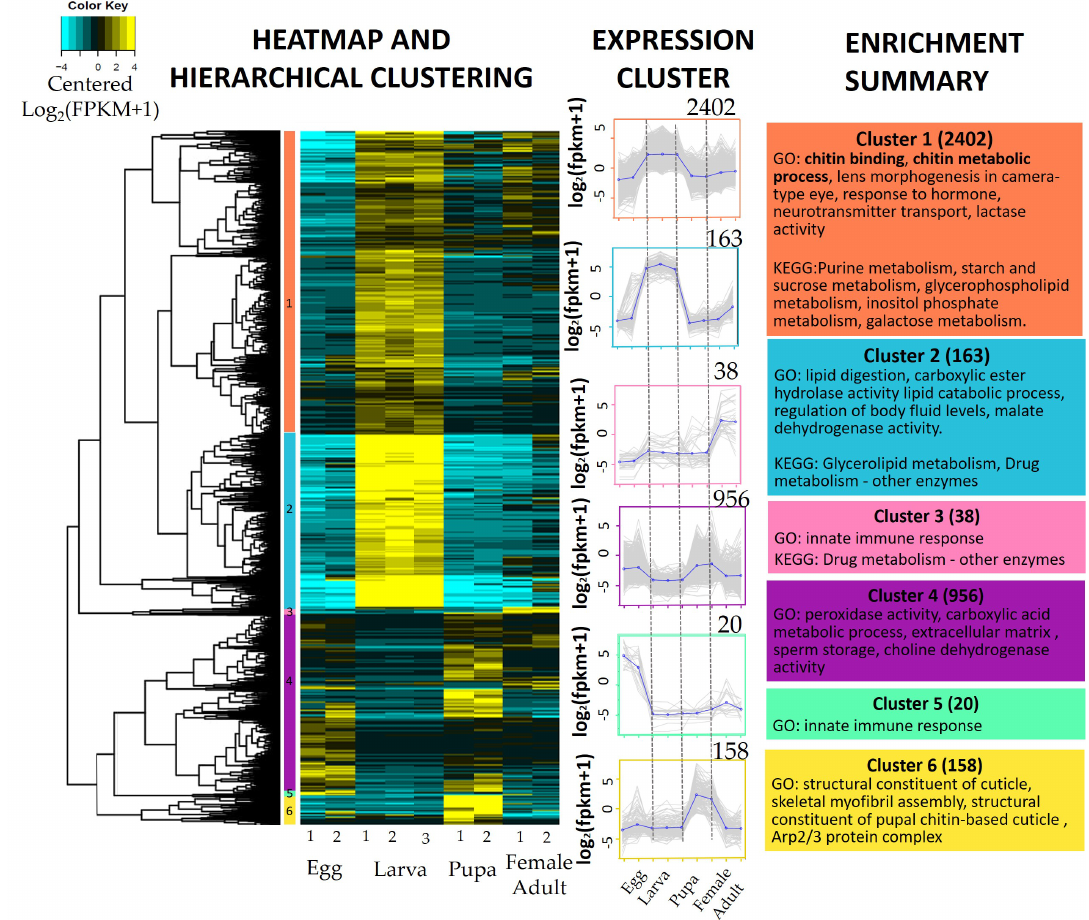
Figure 8. Transcripts expression and cluster enrichment analysis. Heatmap and hierarchical clustering were conducted where 3737 differentially expressed transcripts (DETs) (FDR <0.001, |Log2FC| ≥ 2) were clustered based on Euclidean distance calculated using FPKM-normalised values of each transcript. The hierarchical tree was cut at 0.6 height of the tree to produce six expression clusters with the same expression pattern across the developmental stages. Each cluster was analysed for Gene Ontology Enrichment analysis using Gene Set Enrichment Analysis (GSEA) ( q < 0.05) and KEGG enrichment analysis using a Hypergeometric test with Bonferroni Correction (Bonferroni-corrected p values < 0.05). The enrichment summary lists selected enriched GO terms and KEGG pathways at each cluster (Supplementary Table S2).